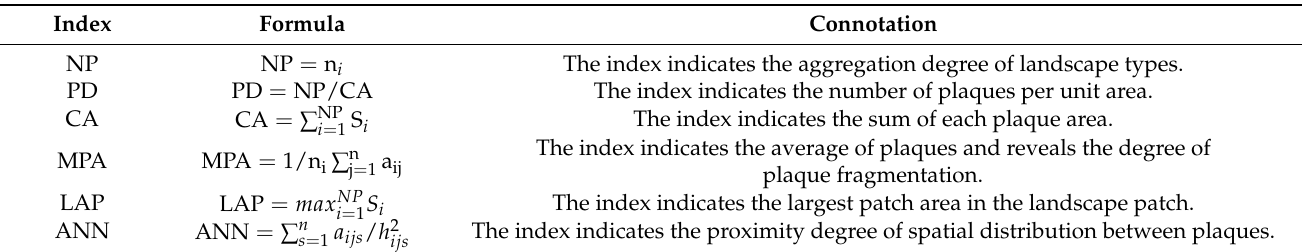
Table 1. Calculation method and connotation of pattern index.